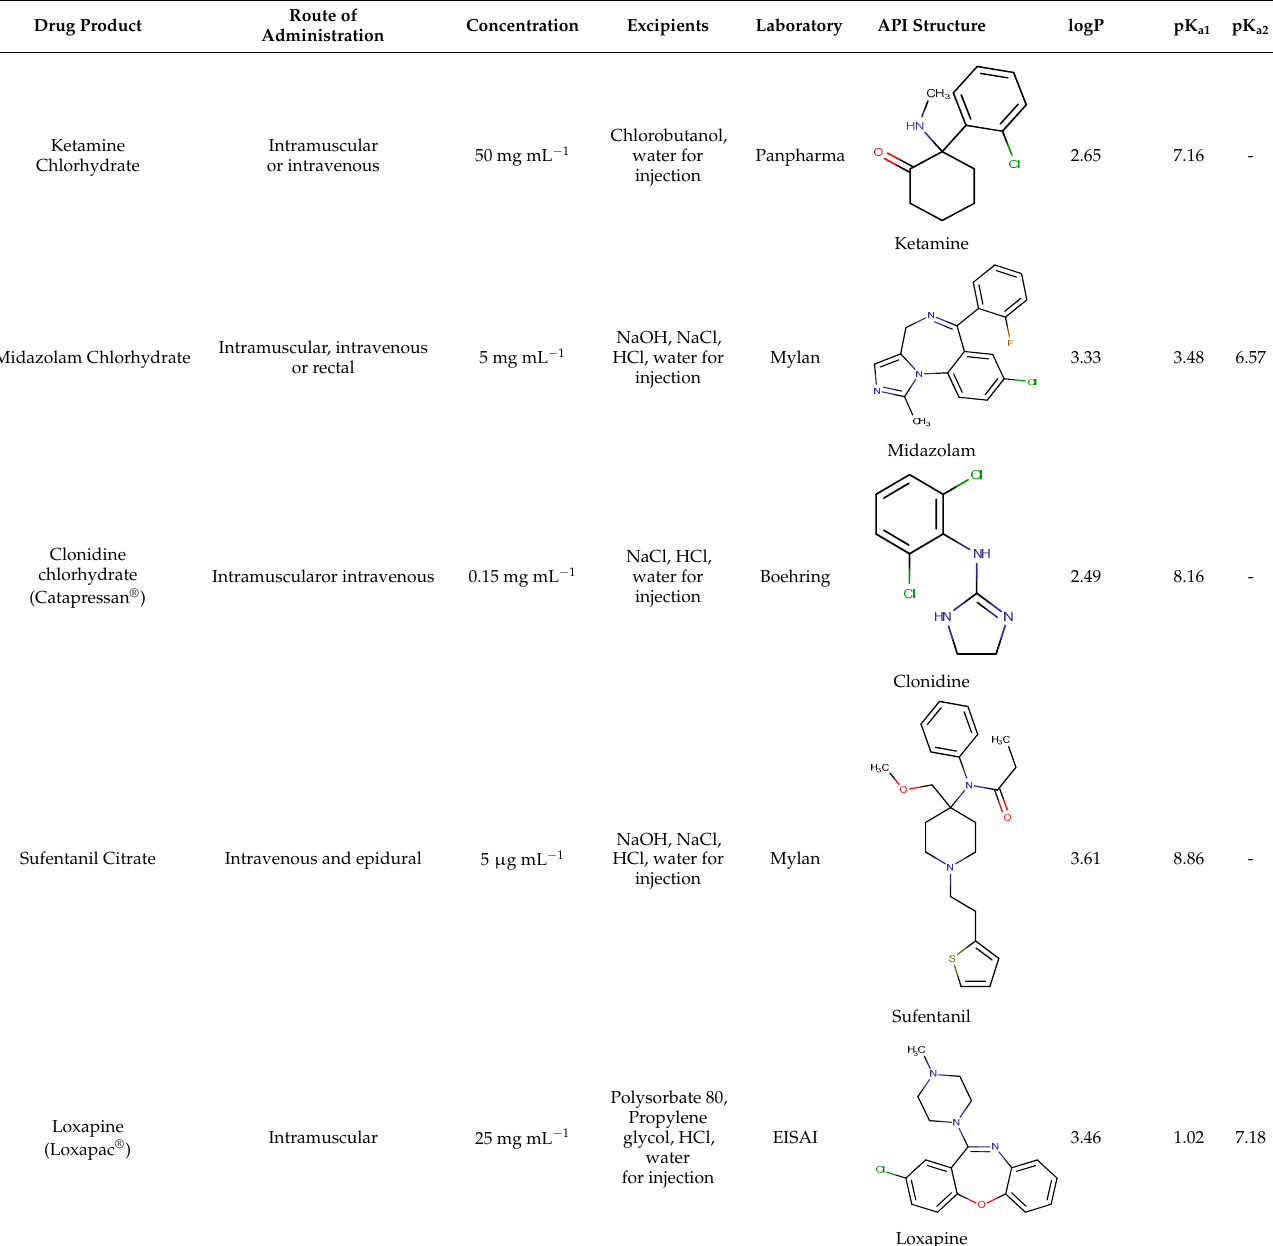
Table 1. Summary of the drugs products and active pharmaceutical ingredient (API) properties.